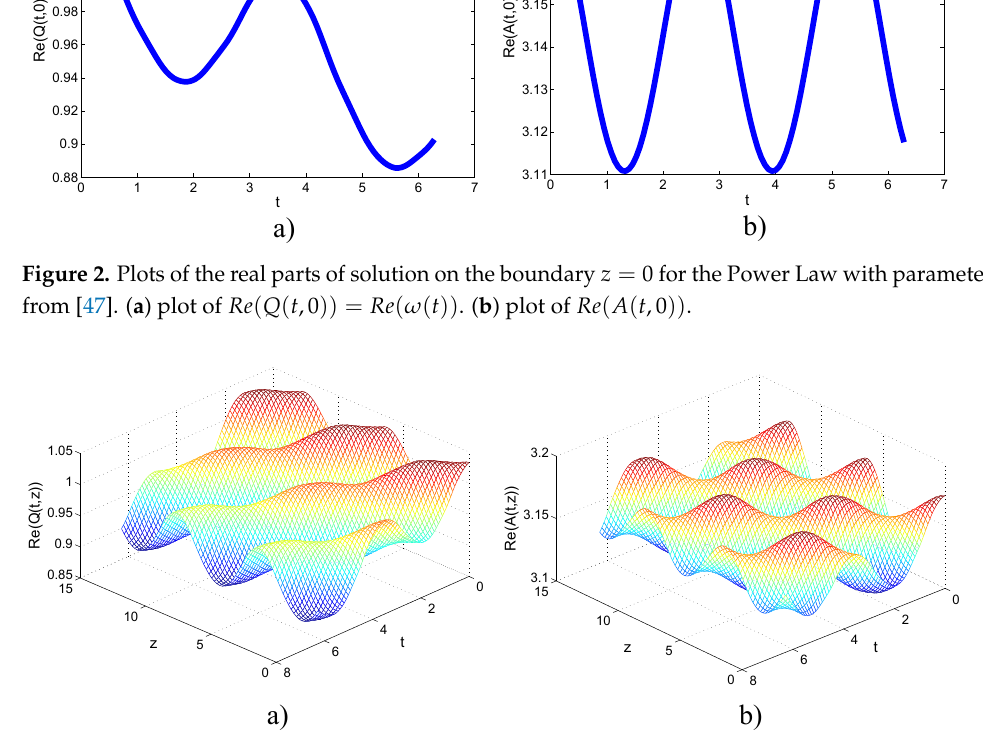
Figure 3. Plots of the real parts of solution for the Power Law with parameters from [47]. ( a ) plot of Re ( Q ( t , z )) . ( b ) plot of Re ( A ( t , z )) .